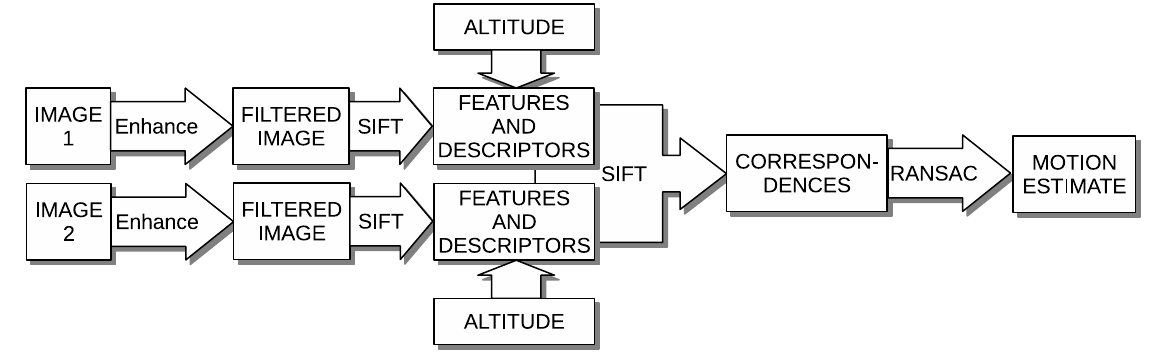
Figure 1. Summary of the proposed image registration process.